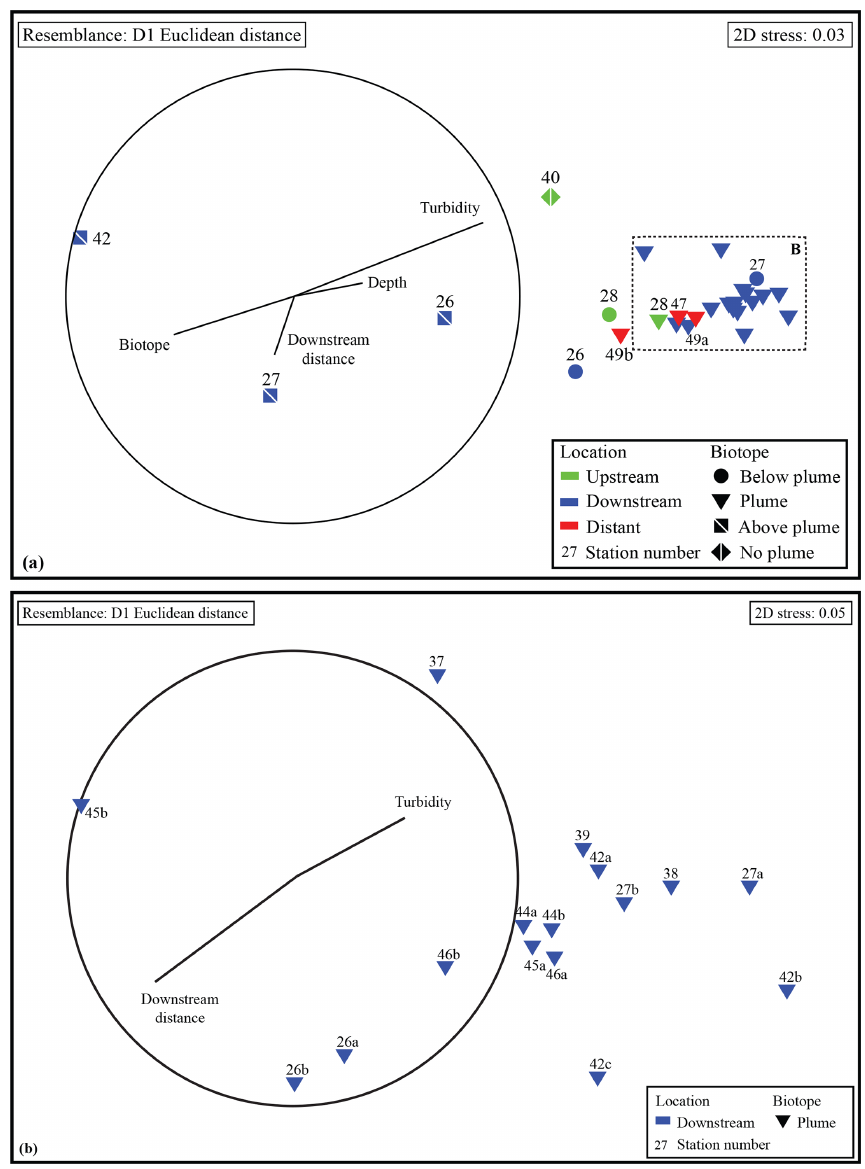
Figure 4. (a) NMDS ordination showing all water samples based on their resemblance in chemical composition. (b) NMDS ordination showing all plume samples from the downstream stations based on their resemblance in chemical